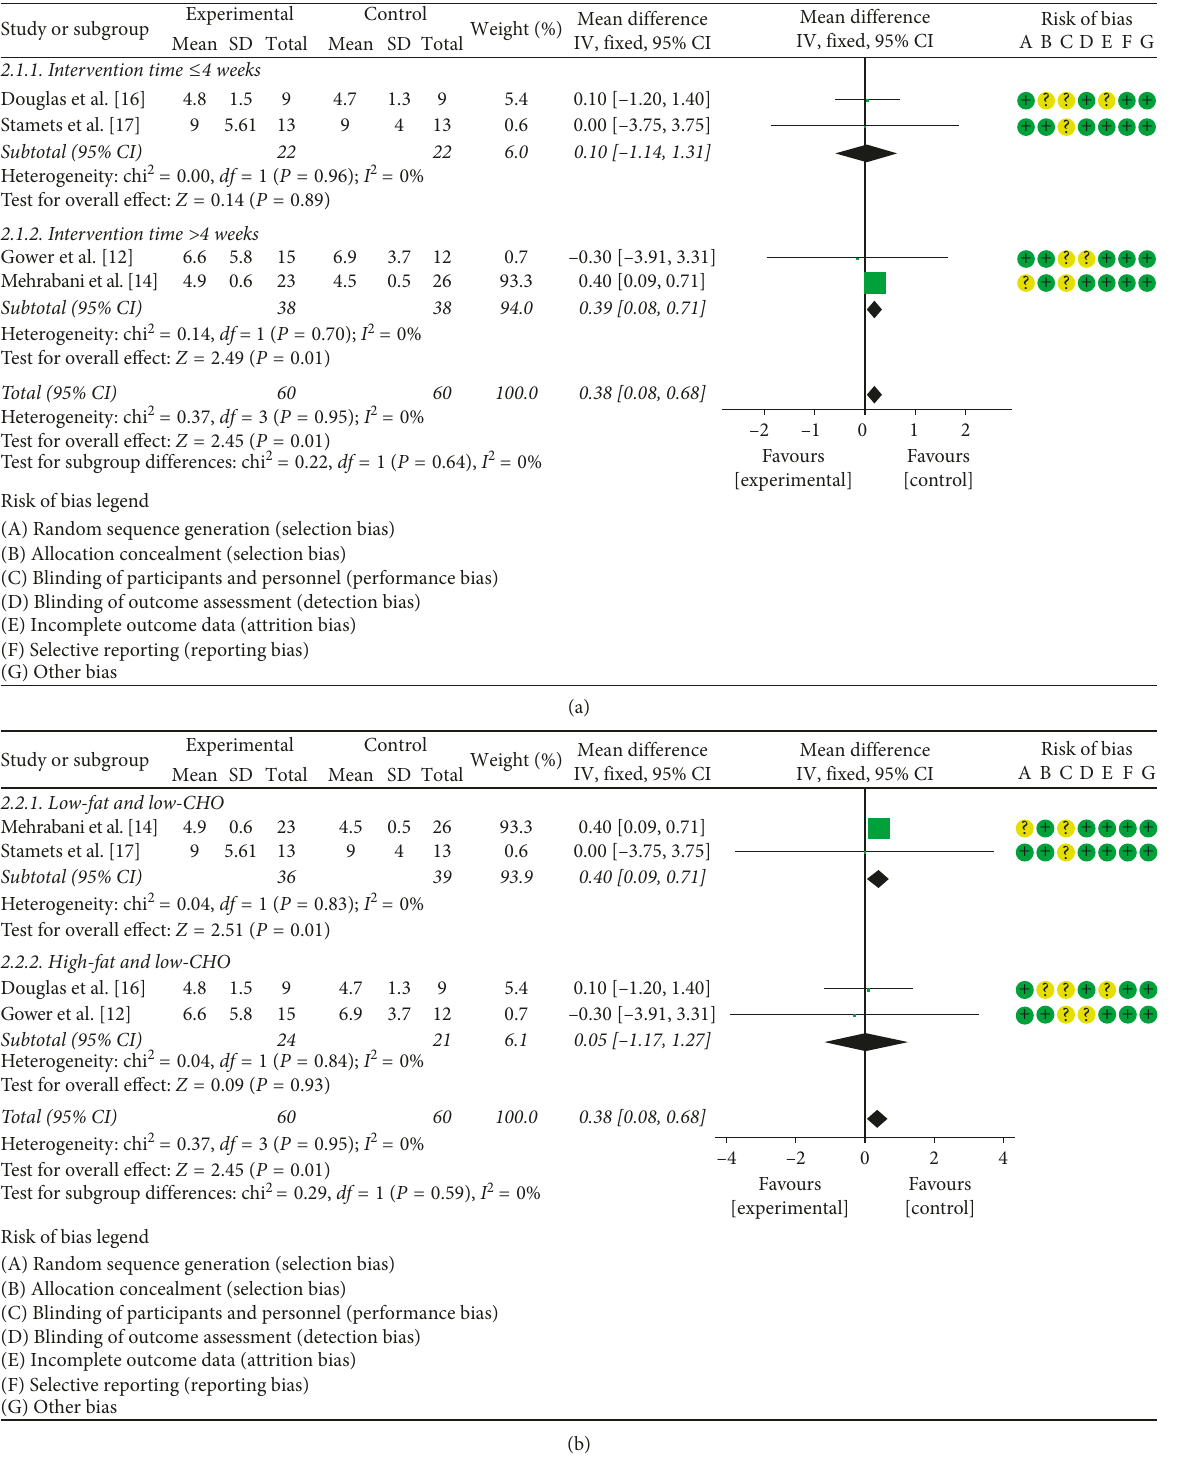
Figure 5: Meta-analysis of the effect of (a) LCD duration on FSH levels in PCOS patients and (b) LCD type on FSH levels in PCOS